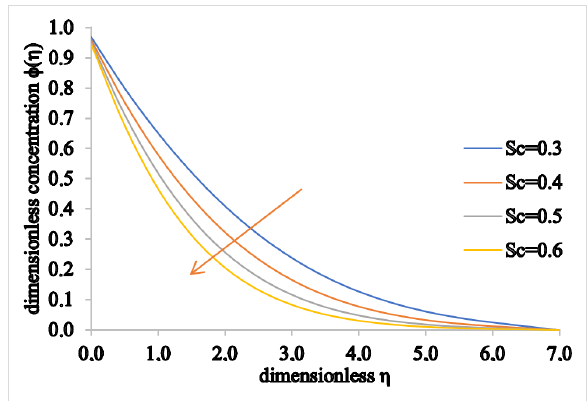
crease in the chemical molecular diffusion rate and, conse- quently, both the concentration of the fluid and the associated concentration boundary layer thickness decrease.